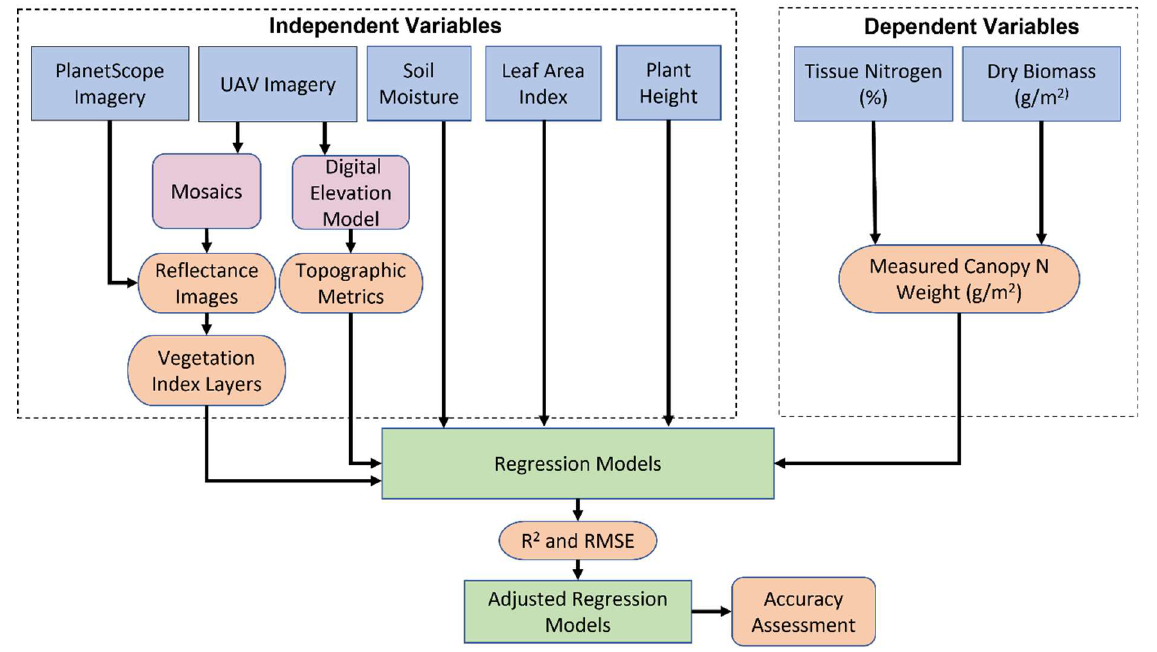
Figure 3. Flowchart of the methodology used in the study.